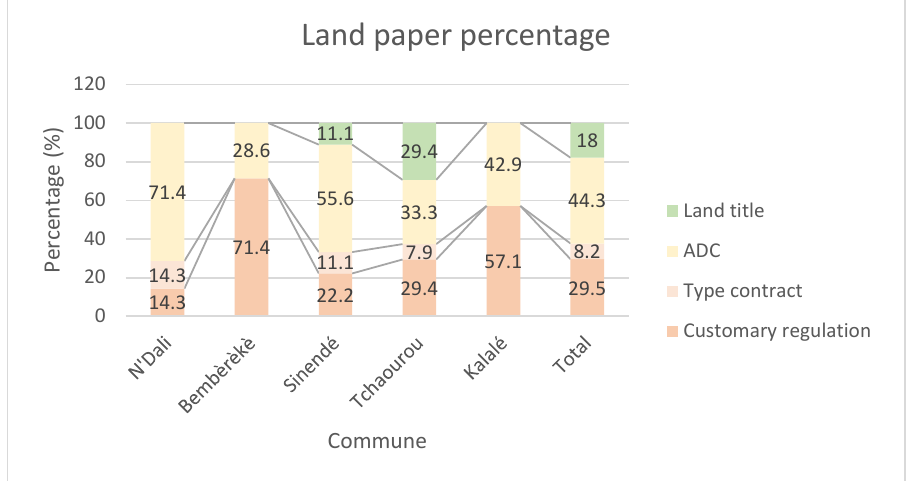
Figure 4. Types of land documents.